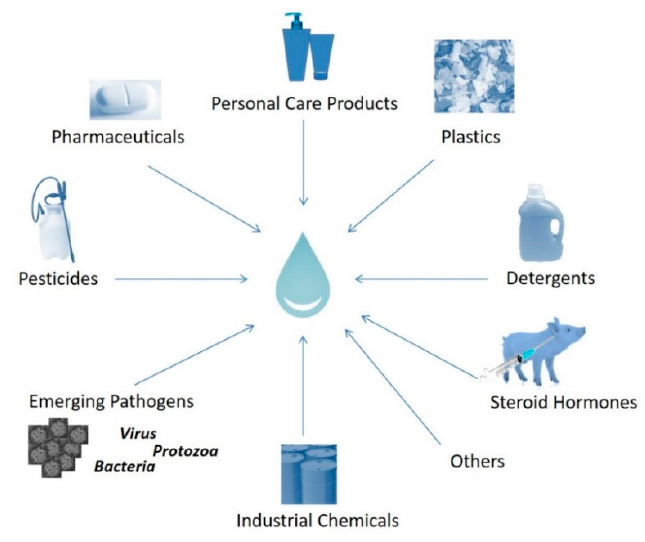
Figure 2. Water contaminants of emerging concern.